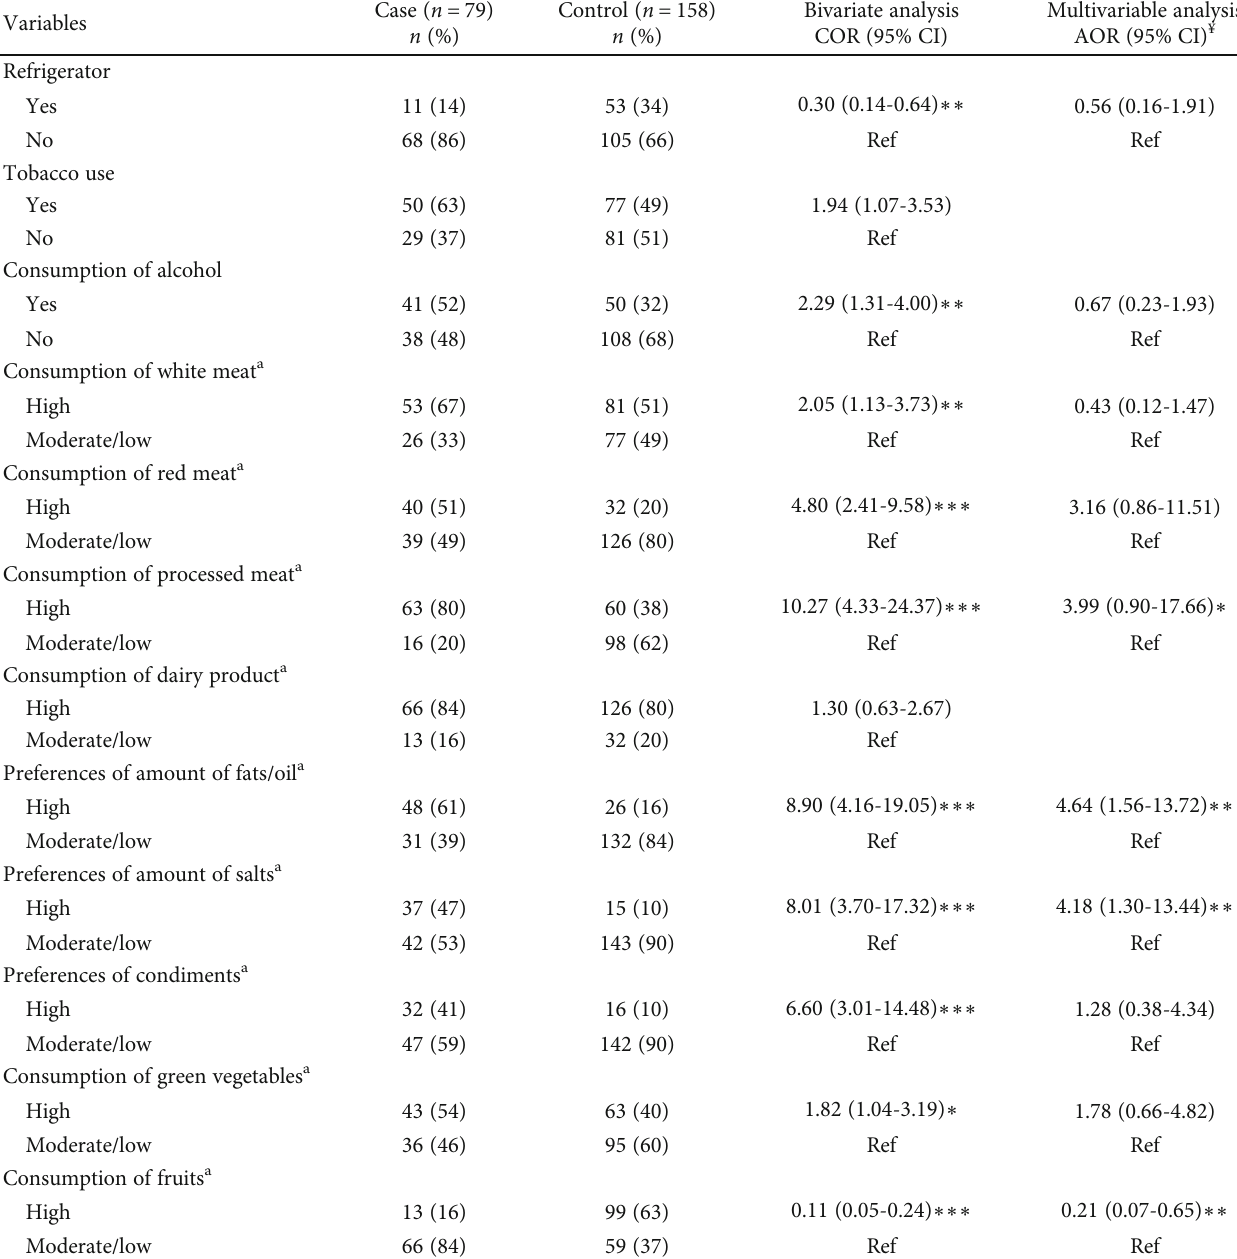
Table 2: Association of dietary and lifestyle factors with the risk of gastric